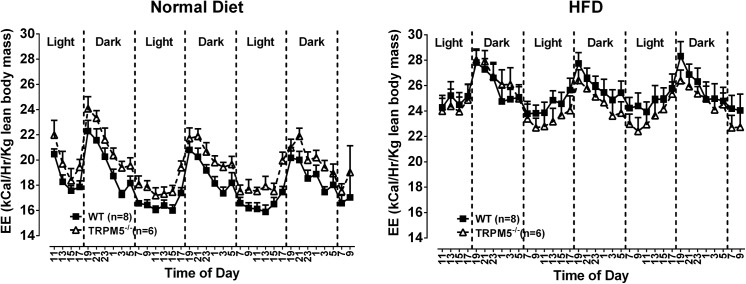
Energy expenditure test in male Trpm5
-/- and wild type mice.Time course of energy expenditure calculated on lean body mass during 72 hours before (A) and after (B) being on HFD for 10 weeks, shown on the X-axis are the actual clock hours. Data are presented as mean ± SEM.